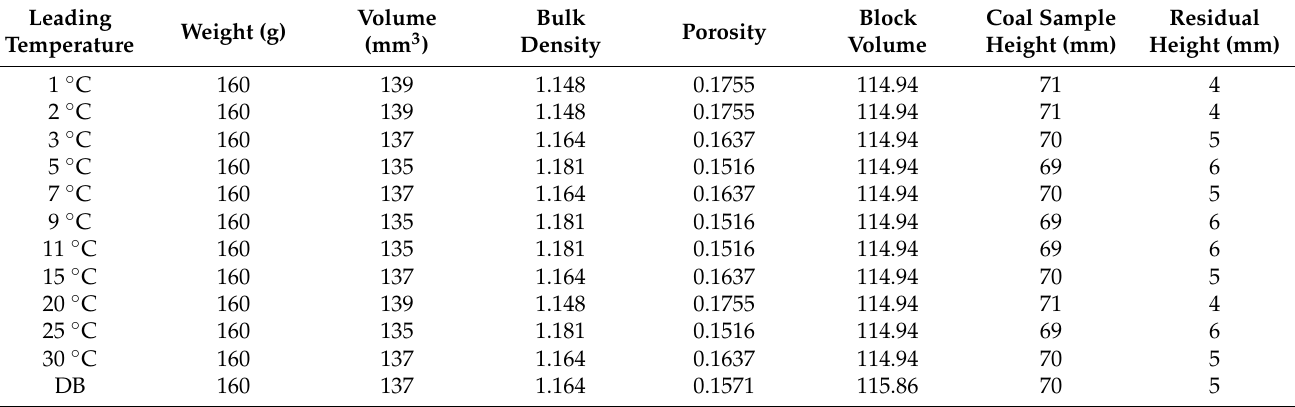
Table 3. Basic parameters of PS and